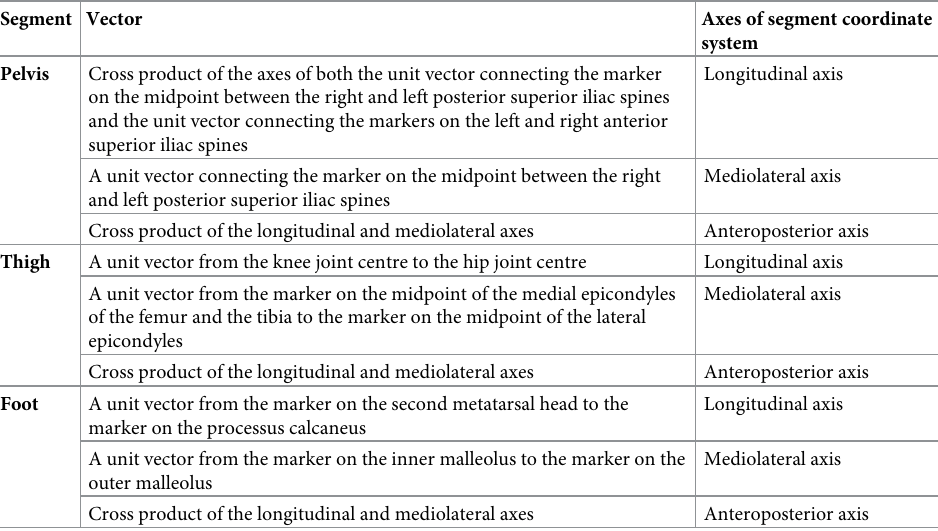
Longitudinal axis Mediolateral axis Mediolateral axis